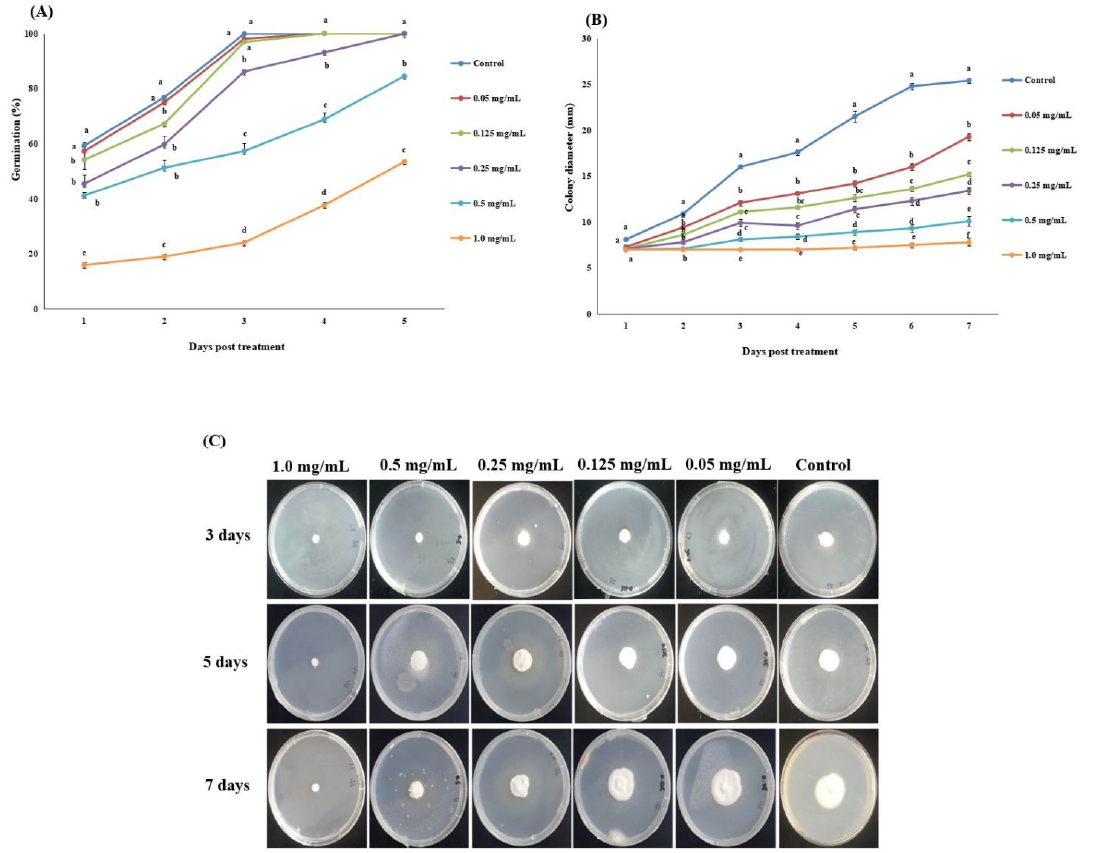
Figure 1. Influence of matrine biological characteristics of A. attenuatus. ( A ) Germination rate (%); ( B ) Colony diameter; ( C ) Growth of A. attenuatus on PDA plates supplemented with different concentrations of matrine. Error bars indicate standard error of means based on three replicates. Bars having different letters at different days post treatment were significantly different from each other.